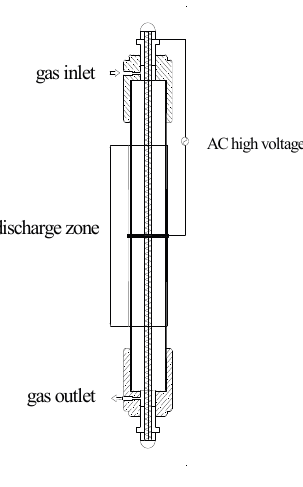
Figure 1. Schematic of the DBD plasma